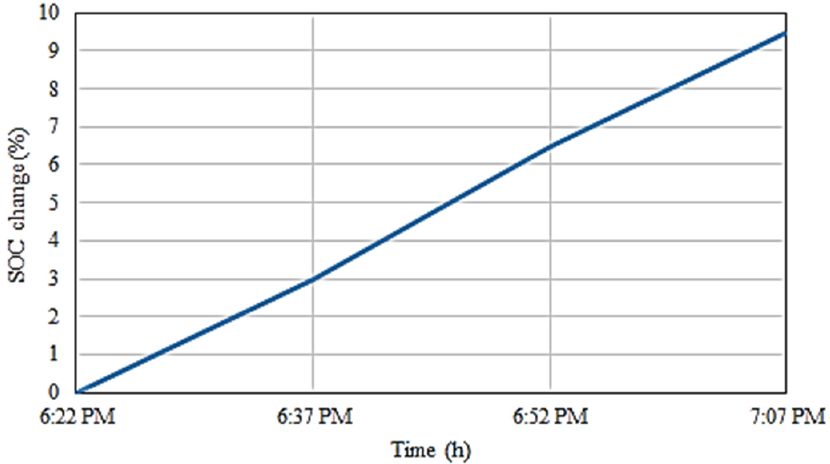
Figure 13. Change in the battery SOC during charging for Test 4.